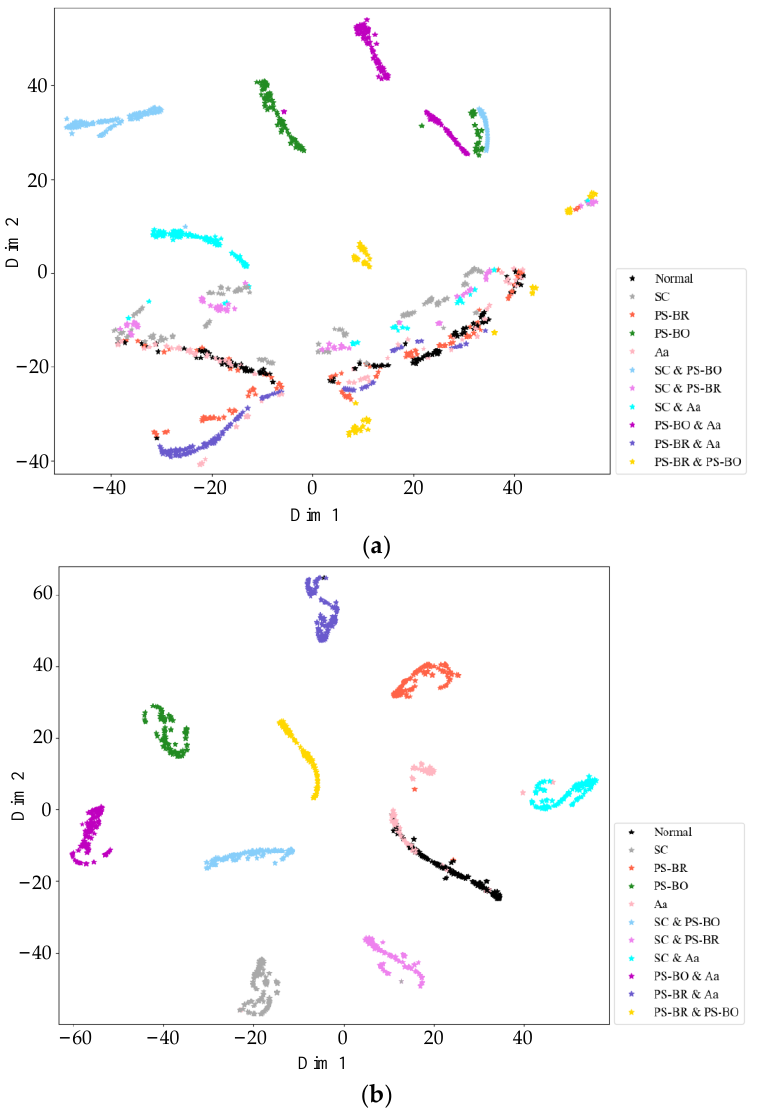
Figure 6. t-SNE visualization result of measured experiment. ( a ) Original data; ( b ) Output data.